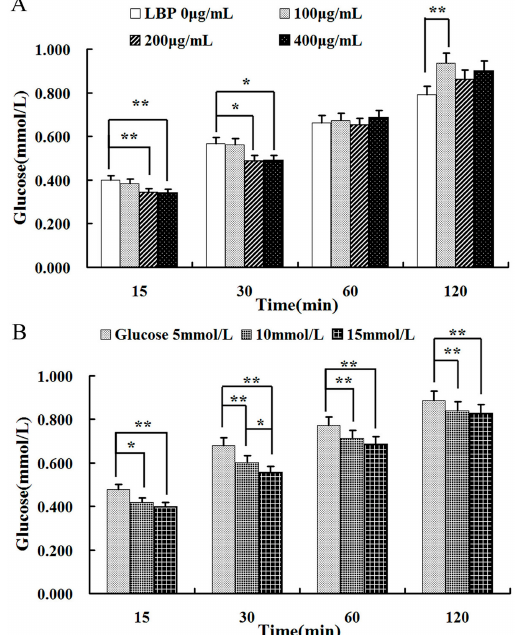
Figure 6. The uptake of LBP on absorption of glucose in Caco2 cells. ( A ) Caco2 cells were treated with glucose (10 mmol/L) and different concentrations of LBP (0, 100, 200 and 400 μ g/mL) for 120 min; ( B ) Caco2 cells were treated with LBP (200 μ g/mL) and different concentrations of glucose (5, 10 and 15 mmol/L) for 120 min. The data are presented as the mean ± SD ( n = 3). The asterisk indicate a significant difference among samples, * p < 0.05; ** p < 0.01 (ANOVA followed by SNK-q test).